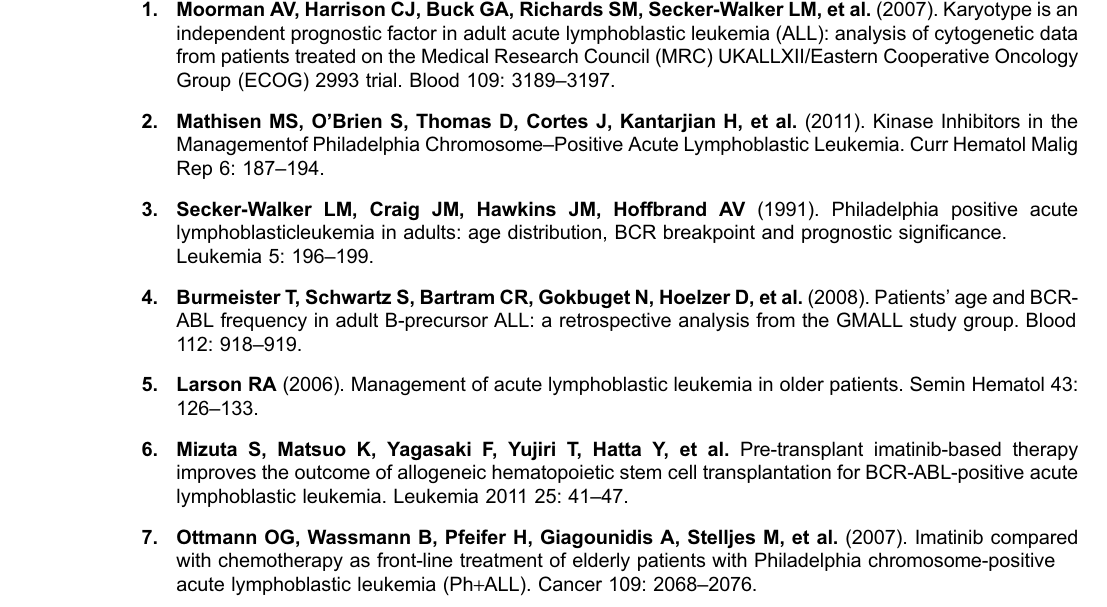
Table S1. The correlation coefficients between the Schoenfeld residuals versus the ranks of survival time and event-free